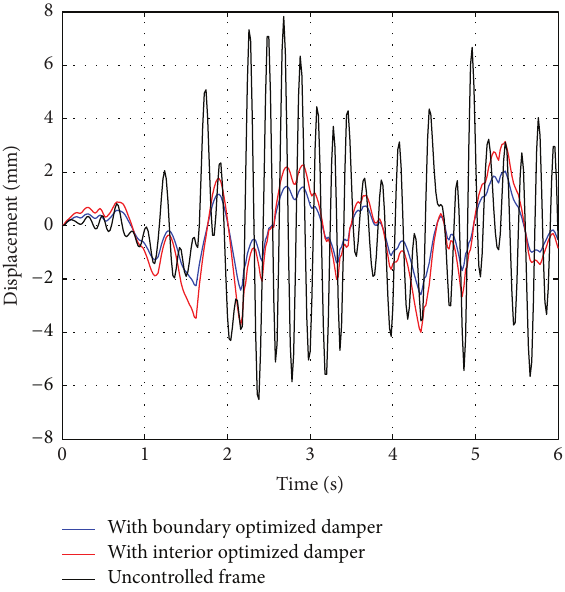
Figure 31: Time-history curve under small earthquake.